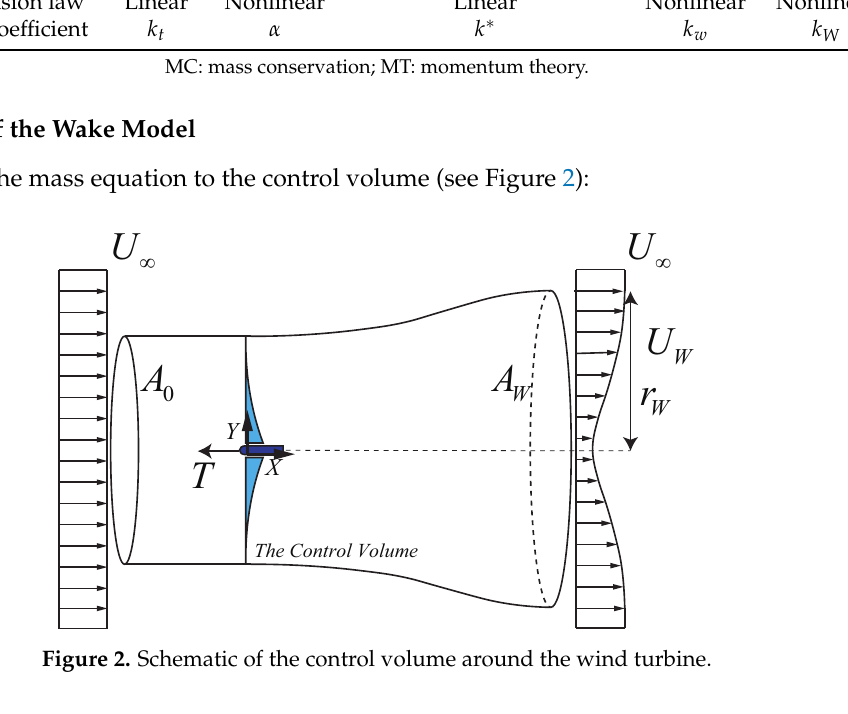
Table 1. Comparison between the proposed model and the previous wake models. Characteristics Jensen Frandsen Bastankhah & Porté-Agel Tian Proposed Profile Top-hat Top-hat Gaussian Cosine Cosine Principles MC MC&MT MC&MT MC MC&MT Wake expansion law Linear Nonlinear Linear Nonlinear Nonlinear Expansion coefficient k t α k ∗ k w k W